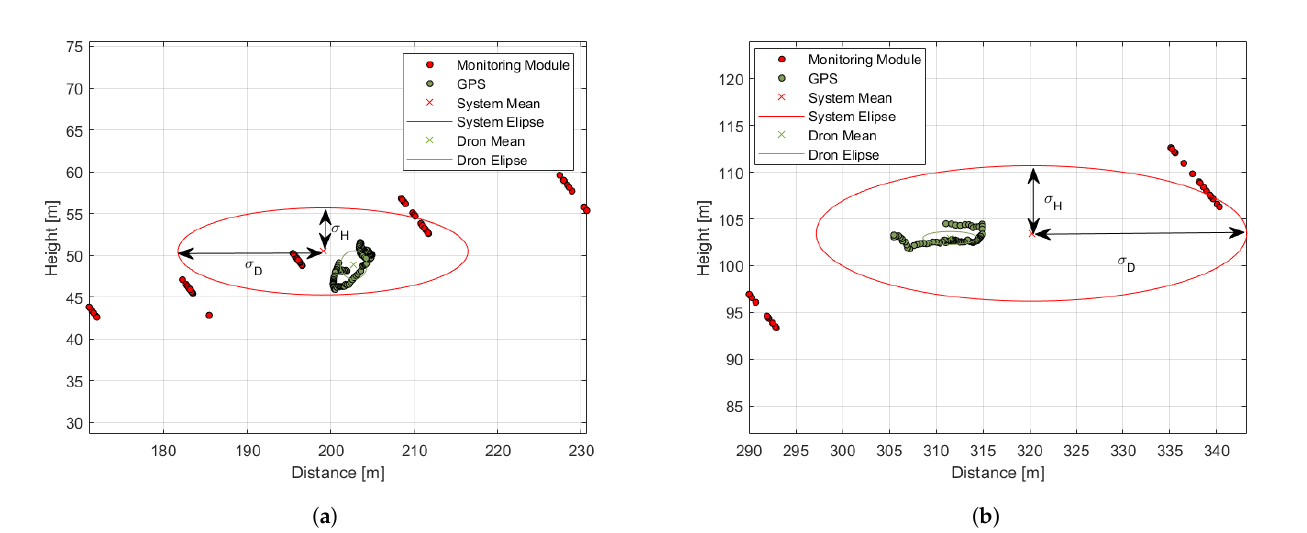
Figure 17. Graphical representation of the tests results. Distance from a monitoring module vs. the height of the drone during the test. Green dots: GPS data; red dots: data from the module. The corresponding color ellipses illustrate the standard deviations of the respective distance and height measurements. ( a ) Scenario VI; ( b ) Scenario